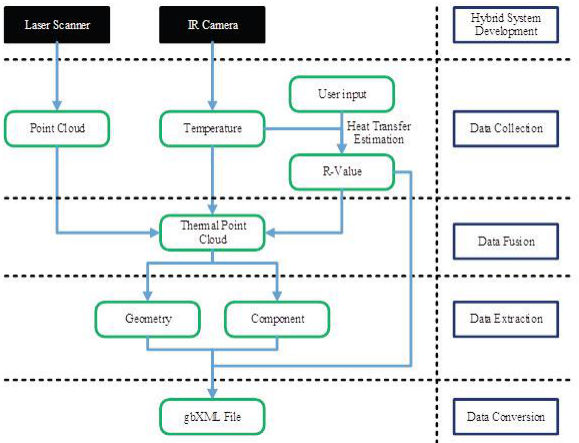
Figure 9: Framework for sustainability assessment proposed by (Wang and Cho,